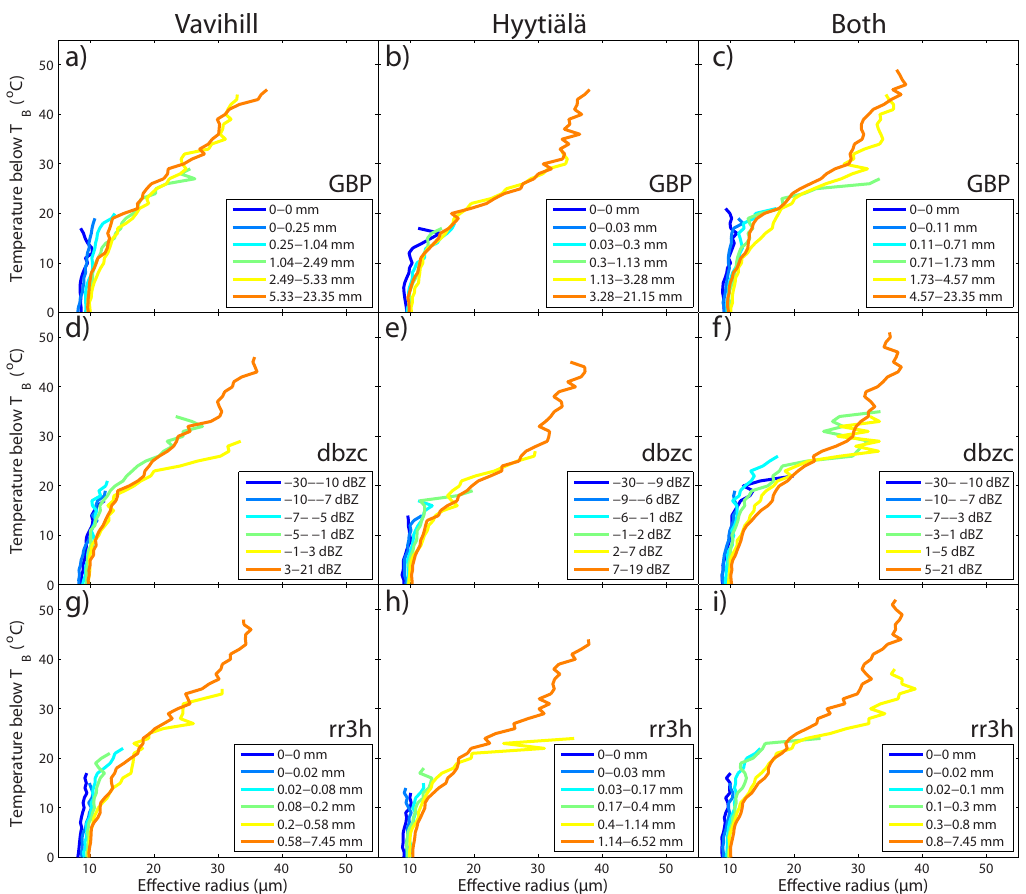
Fig. 6. Average effective radius profiles for 6 percentiles of the data according to the GBP (row 1), dbzc (row 2) and rr3h (row 3) for Vavihill (column 1), Hyytiälä (column 2) and both datasets combined (column 3). GBP is the ground-based precipitation accumulated over 24h, dbzc is the reflectivity factor from ground-based weather radars and the rr3h is the accumulated precipitation for a 3h period from the weather